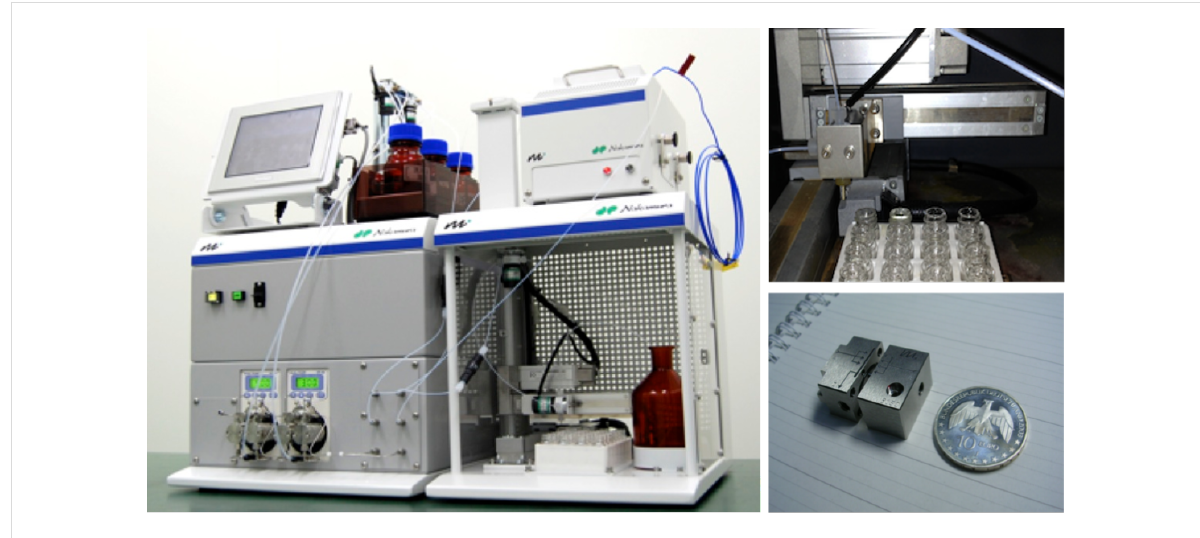
Figure 1: Pictures of the flow microreactor system (MiChS® System X-1), a micromixer (MiChS β -150, channel width: 150 μ m), and a fraction collector used for this study.